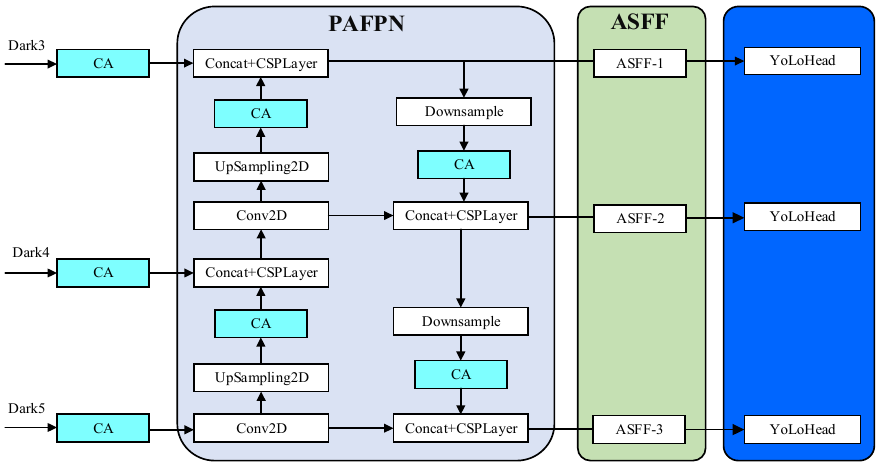
Figure 9. Improvement scheme of YoLoX-Nano network